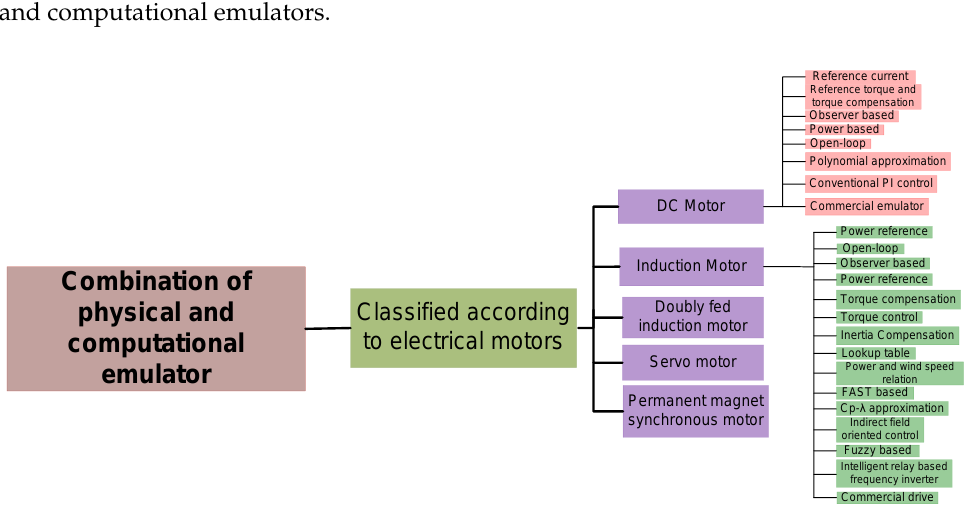
Figure 2. Classification of a combination of the physical and computational